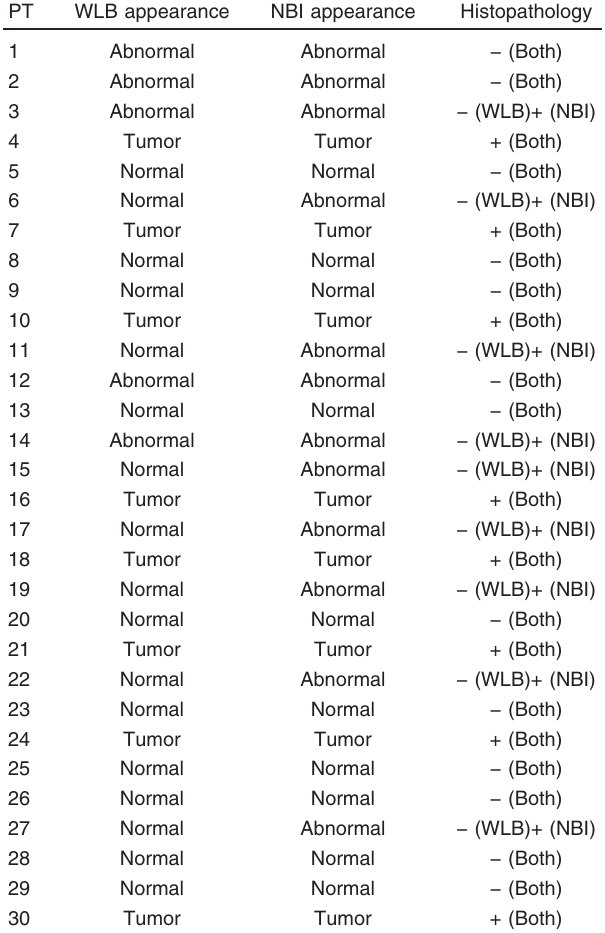
Table 6 Naked eye appearance of the white-light bronchoscope and narrow band imaging with the histopathological results